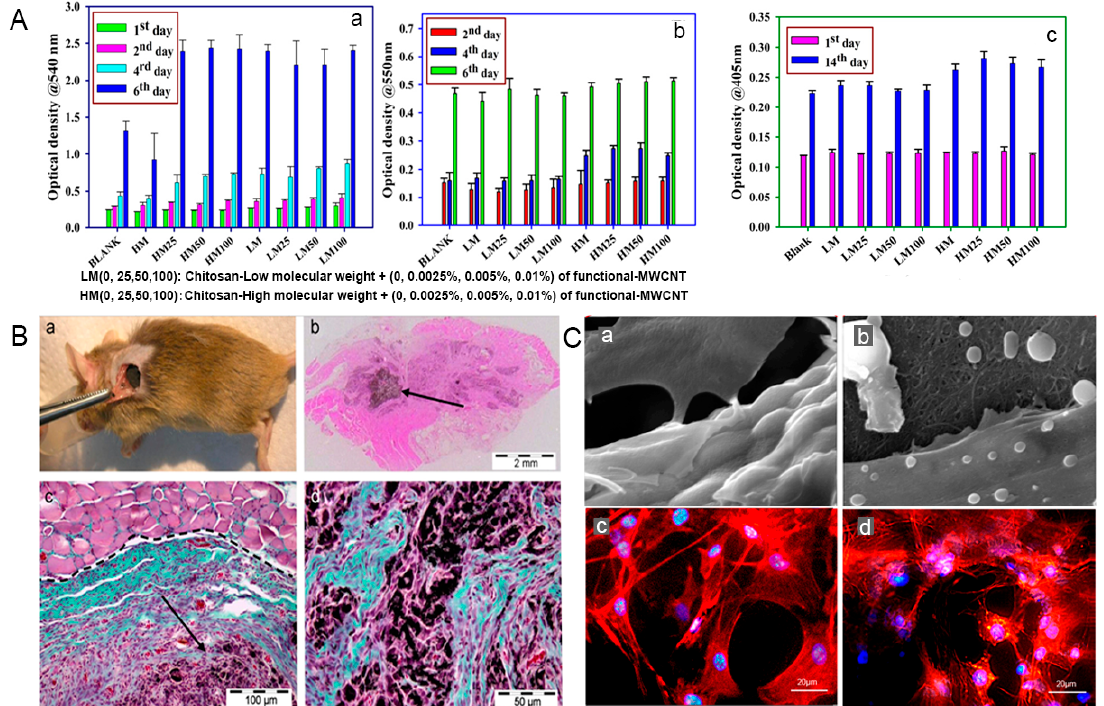
Figure 3. Carbon nanotube-reinforced chitosan (CNT-CS) biomaterials with in vivo and in vitro bioactivity and mechanical strength. ( A ) MTT assay of the viability of an MG-63 osteoblast-like cell; ( b ) protein estimation; and ( c ) Alkaline phosphatase (ALP) activity of an osteoblast-like MG-63 cell on different CS–MWCNT composite scaffolds as a function of time. ( B ) The surgical implantation of ( a ) rhBMP-2 adsorbed MWCNT–CS scaffolds into the subcutaneous muscular pocket of a mouse; ( b ) optical microscope micrograph of regenerated bone tissue; ( c , d ) optical micrograph in detail of regenerated bone tissue (blue–green), the remaining scaffold (black), and plenty of fibroblasts (purple colored) after major disassembly of the MWCNT/CS scaffold, surrounded by muscle tissue (pink). ( C ) MC3T3-E1 cells spreading on interconnected porous HA ceramic ( a , c ) and 3D-porous CNT ( b , d ) scaffolds (actin filaments: red; nucleus: blue). Reproduced with permission from [159,163,164] . Elsevier, 2012, 2008; MDPI: Open Access, 2017.